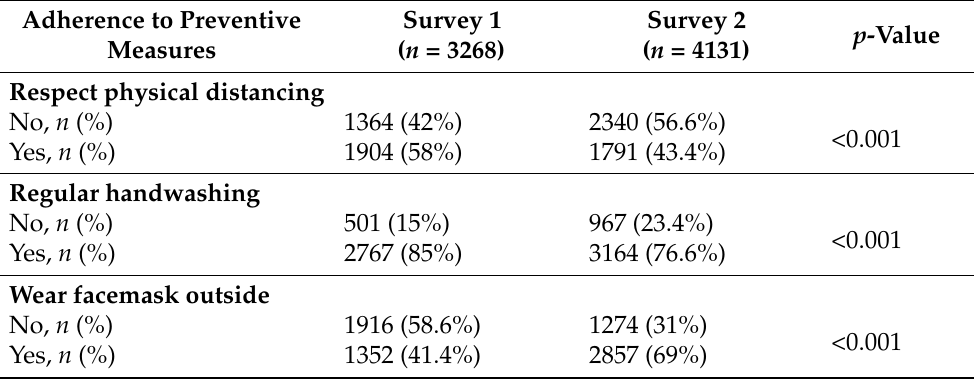
Table 3. Adherence to preventive measures during the first and second